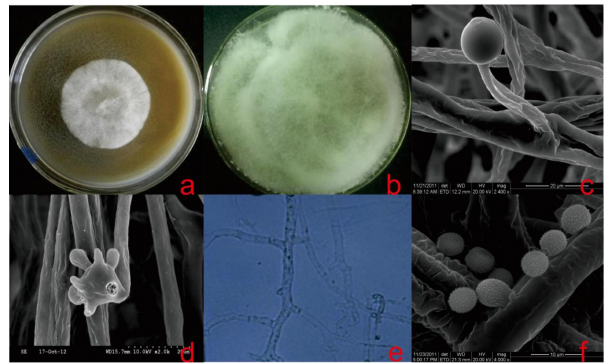
Figure 2. Apophysomyces jiangsuensis . ( a ) Fungal colony after 72 h on PDA; ( b ) covered the Petri dish after 5 days on MAM; ( c ) sporangiophores and sporangia; ( d ) forming spores and hyphae; ( e ) septum in the hypha; and ( f )